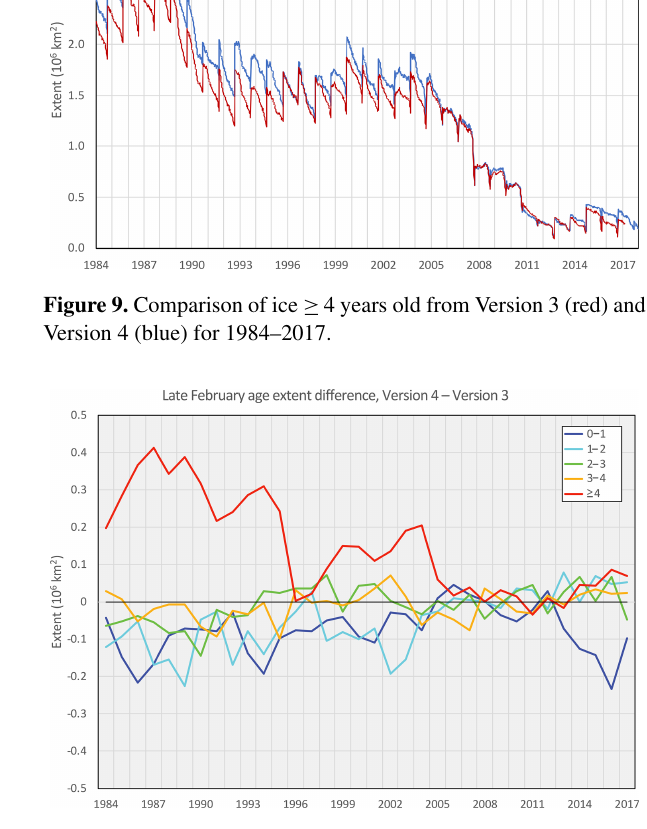
Figure 10. Extent difference between Version 4 and Version 3 sea ice age categories for the week of 19–25 February from 1984 to